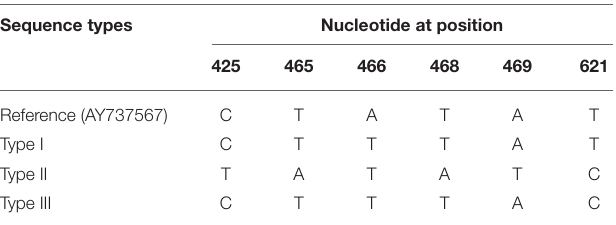
TABLE 2 | Variations in the SSU nucleotide sequences among Cryptosporidium environmental sequences in the present study. Sequence